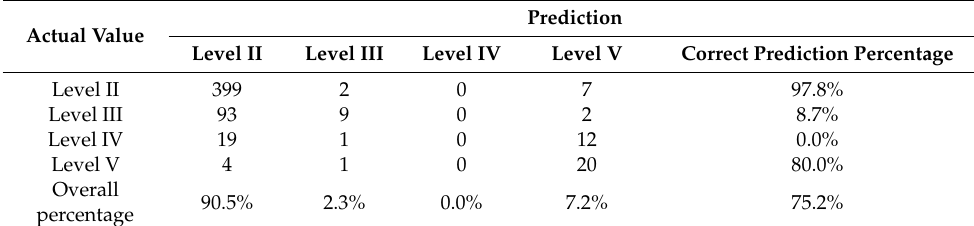
Table 3. The confusion matrix of the decision tree